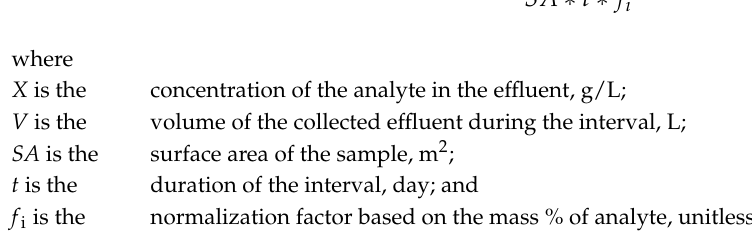
Figure 6. Microstructure of the SFA SPS-2 sample shown by: ( a ) SEM micrograph; and the corresponding EDS maps of: ( b ) Ag; ( c ) I; ( d ) S; and ( e )